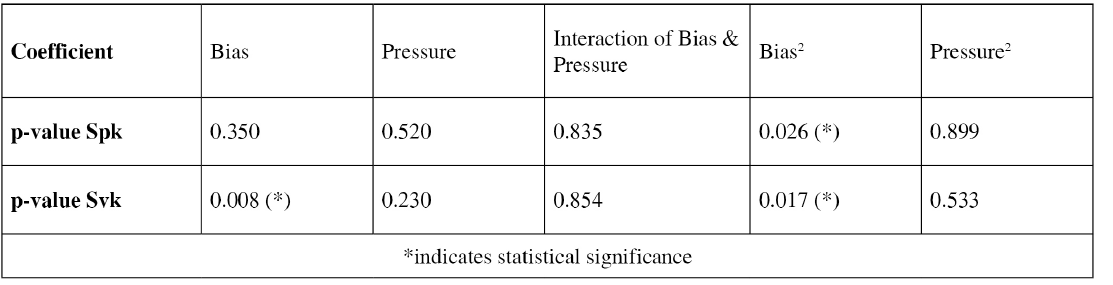
Figure 7. Scatter plot and response surface of surface roughness Spk and Svk (as coated).